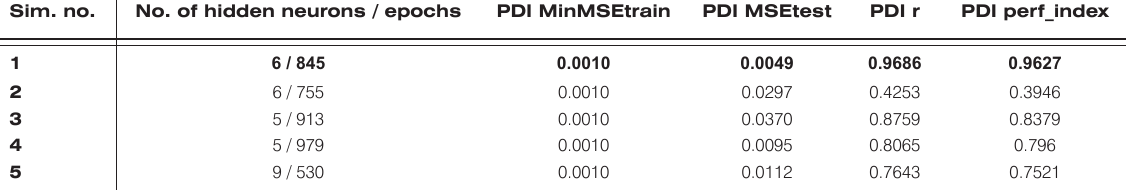
Table 4. The results of the simulations for optimizing the number of hidden neurons for the neural network modelling the polydispersity. Sim. no.